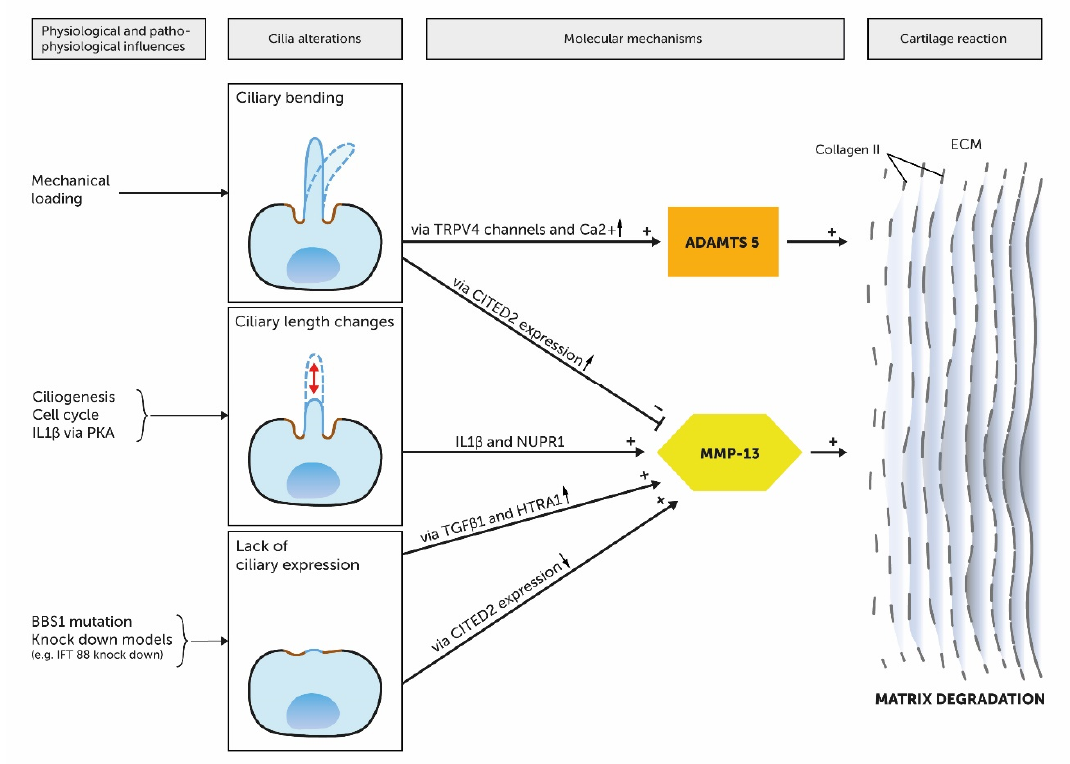
Figure 6. Short summary of the ciliary involvement in molecular mechanisms in the context of OA. Cilia alterations are influenced by physiological and pathophysiological processes and affect molecular mechanisms of OA. Ciliary bending leads to increased calcium levels via TRPV4 channels and subsequently to an activation of the ADAMTS5 gene expression. Furthermore, cyclic mechanical loading can suppress MMP-13 via upregulation of CITED2 expression. In addition, ciliary length changes were reported in the context of OA. IL1 β treatment leads to an elongation of the cilium via Proteinkinase A (PKA). IL1 β in interaction with NUPR1 results in increased MMP-13 expression. Experimental knock down of ciliary genes lead to a lack of ciliary expression and subsequently to an activation of MMP-13 expression for example via increased HTRA1 levels (BBS1 mutations) or via downregulation of CITED2 expression (IFT88 knock